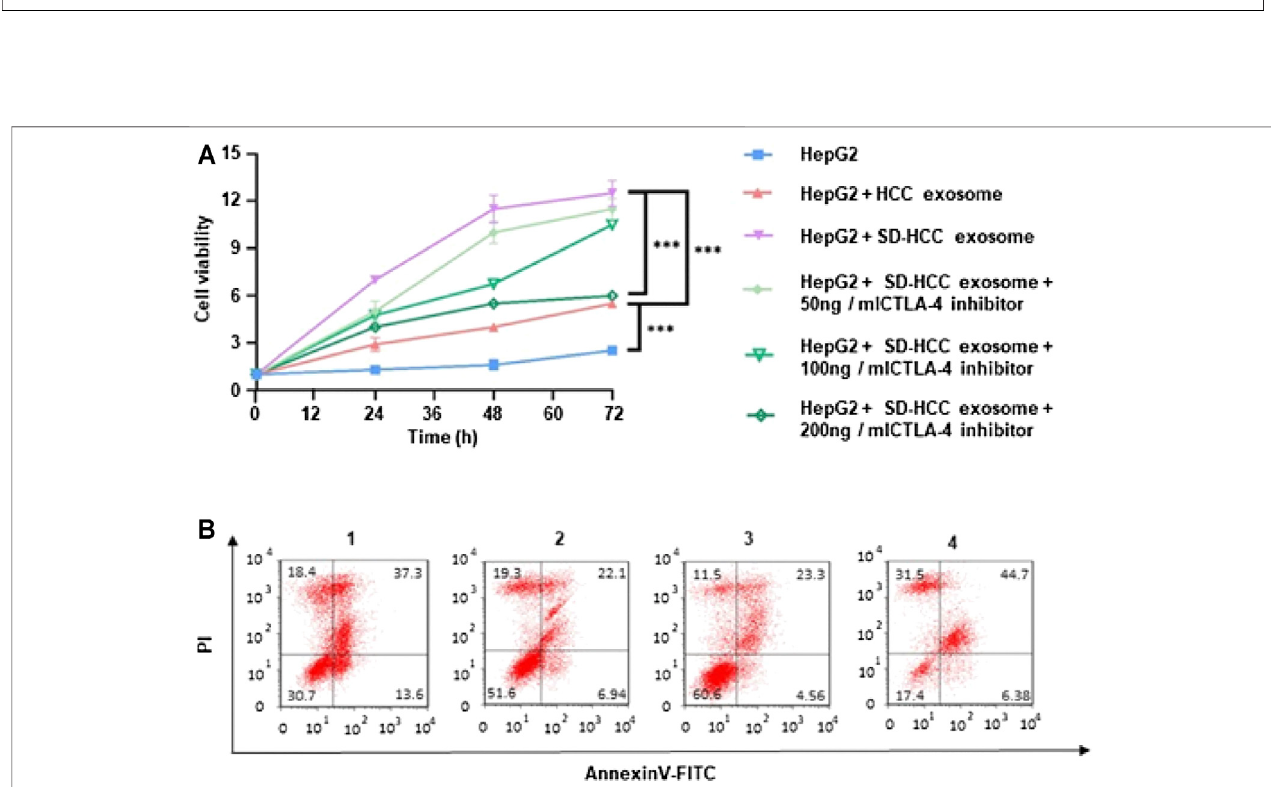
FIGURE3| Invitro evaluation ofcellproliferationofexosomes. (A) Relativecell viabilityofHepG2after 72 hincubation ofHCC exosomes andSD-HCCexosomes; (B) theAnnexinV/PIapoptosisassaywasmeasuredbyFCManalysisofHepG2cellsafterbeingtreatedwitheachgroupfor24 h. n (cid:2) 3, *** p < 0.001.1)HepG2,2)HepG2 + HCC exosome, 3) HepG2 + SD-HCC exosome, 4) HepG2 + SD-HCC exosome + CTLA-4 inhibitor.